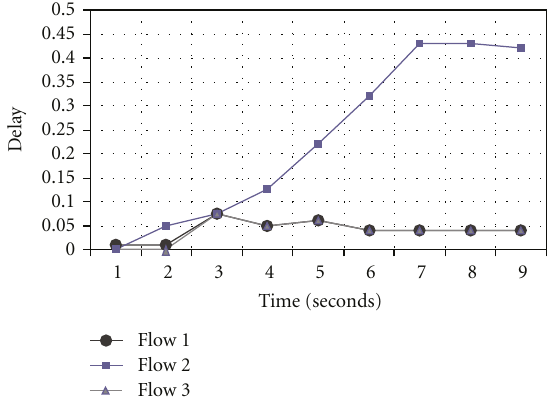
Figure 3: Delay of three flows (1, 2, 3) versus time. RTS/CTS mechanism is